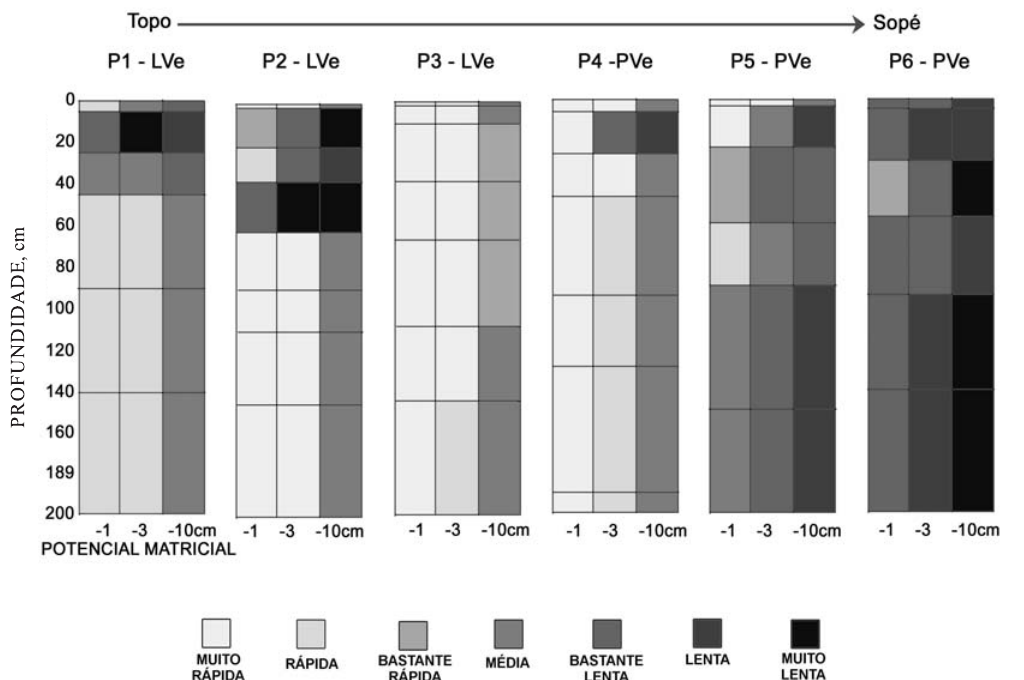
2.Figura 3. Classificação da condutividade hidráulica dos horizontes dos perfis de solo, conforme Aubert